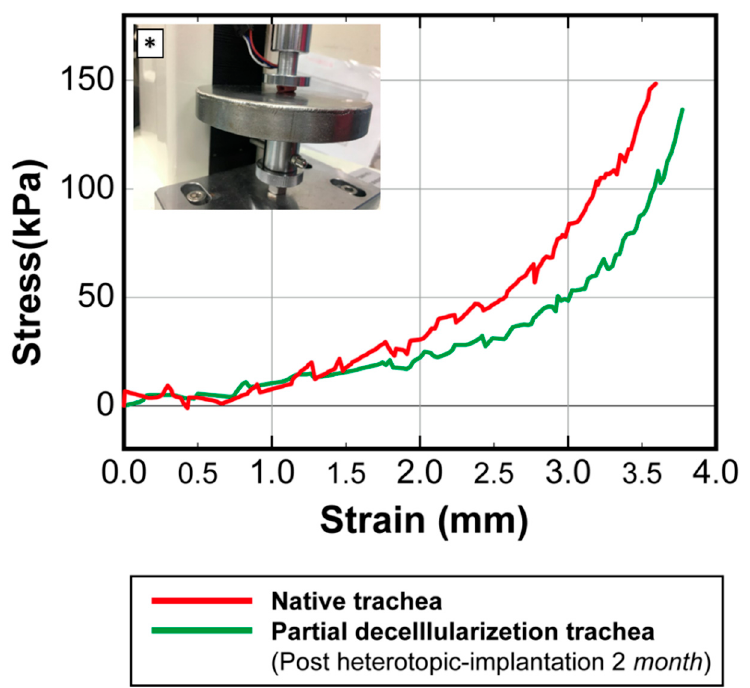
Figure 5. Mechanical strength of the partially decellularized tracheas after 2 months of heterotopic muscle implantation. Compared to that of the native trachea, the curve of the partially decellularized trachea (green curve) showed an approximated similarity, and the mechanical strength was expected to be further restored along with cartilage cell growth. * Mechanical tests under lateral compression settings using a universal testing machine (LF Plus, Lloyd Materials Testing, UK).